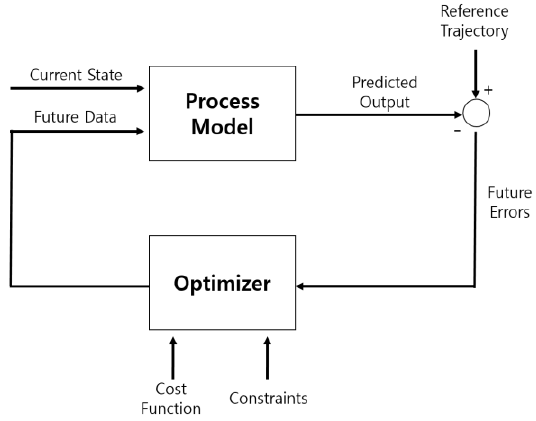
Figure 2. The basic structure of MPC (Model Predictive Control).